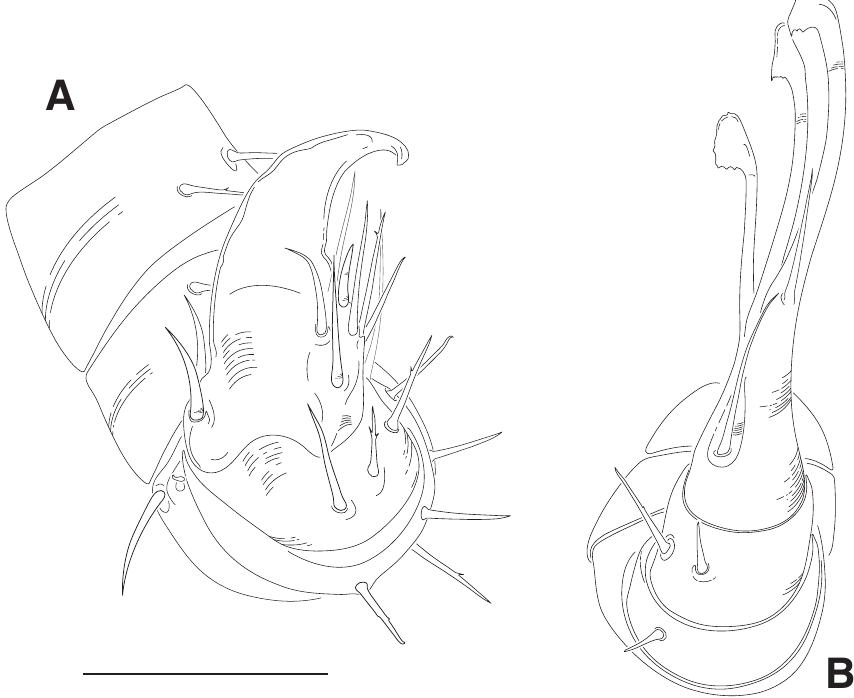
Figure 12. Illacme tobini sp. n.: A spade-shaped anterior gonopod (leg pair 9) B stylus-shaped posterior gonopod (leg pair 10). Scale bar 50 µm. (Catalog #: I. tobini sp. n.